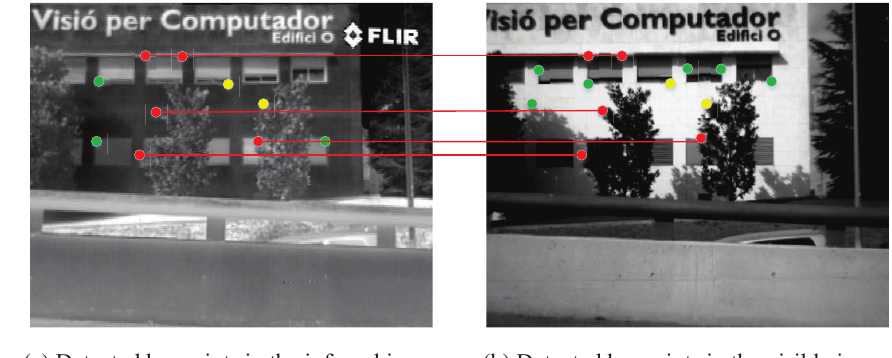
Figure 9. Illustration of the recall rate (RR) for the keypoints.